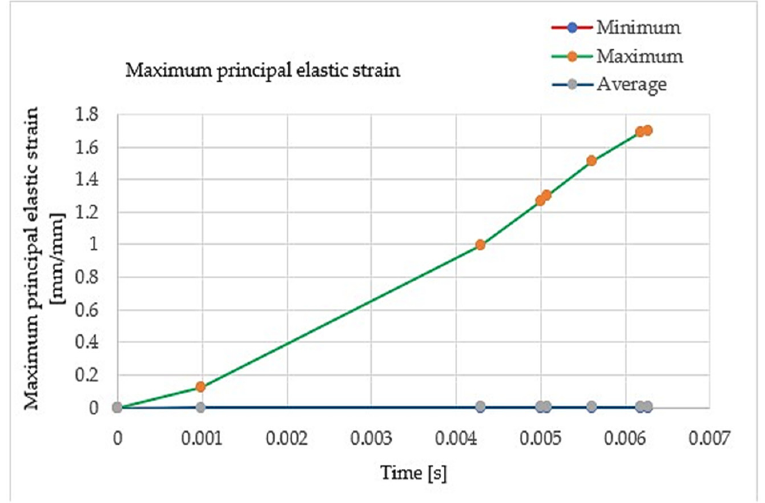
Figure 13. Diagram of maximum principal elastic strain. Table 6. Maximum principal elastic strain.